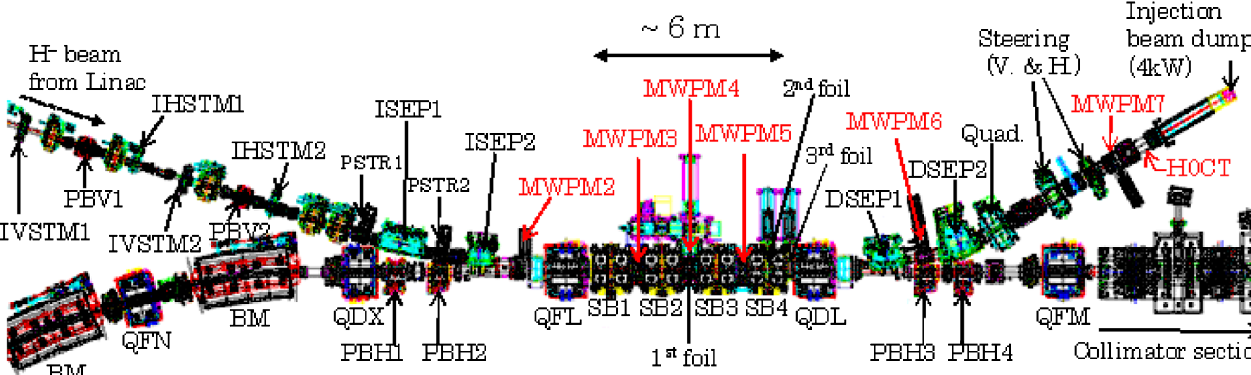
FIG. 1. Layout of RCS injection and successive H0 dump line. The primary stripper foil named as the 1st foil is placed in the middle of four bump magnets (SB1-4). The partially stripped H 0 and unstripped H (cid:1) beams (if any) are stripped to proton beams by two secondary stripper foils, namely, the 2nd and 3rd foils, respectively. They are called waste beam and are transported to the injection beam dump. A current transformer (CT) named H0CT is placed at the end of the dump and is mainly used as a personal protection system (PPS) for the RCS operation. In order to measure as well as for online monitoring of the waste beam at the dump, a signal from the H0CT is used for the present